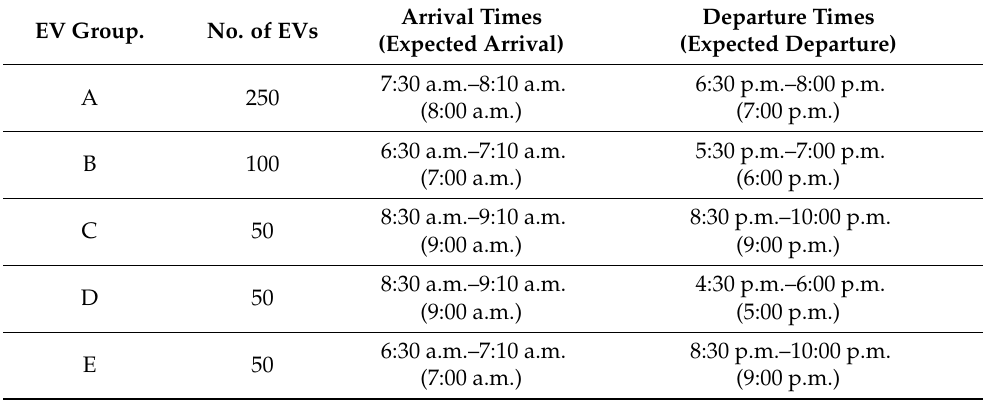
Table 2. EV groups and their respective arrival and departure time ranges to and from the workplace. EV Group.